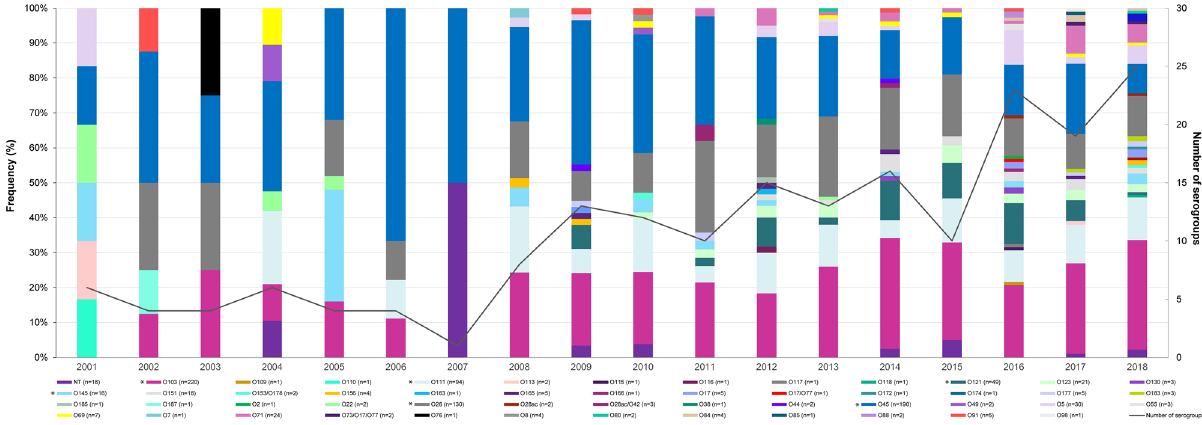
Figure 1. Frequency and number of non-O157 Shiga toxin-producing Escherichia coli serogroups reported in Michigan by year. The y-axis on the left represents the frequency of each serogroup by year and is indicated by the different colored bars. The y-axis on the right shows the number of serogroups per year indicated by the black line. The top six serogroups are indicated with an * in the figure legend. NT